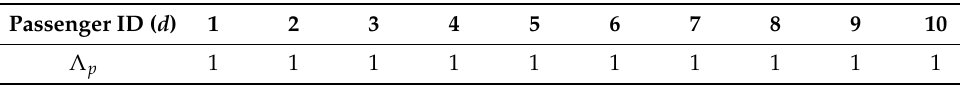
Table 13. Λ p for Passengers.